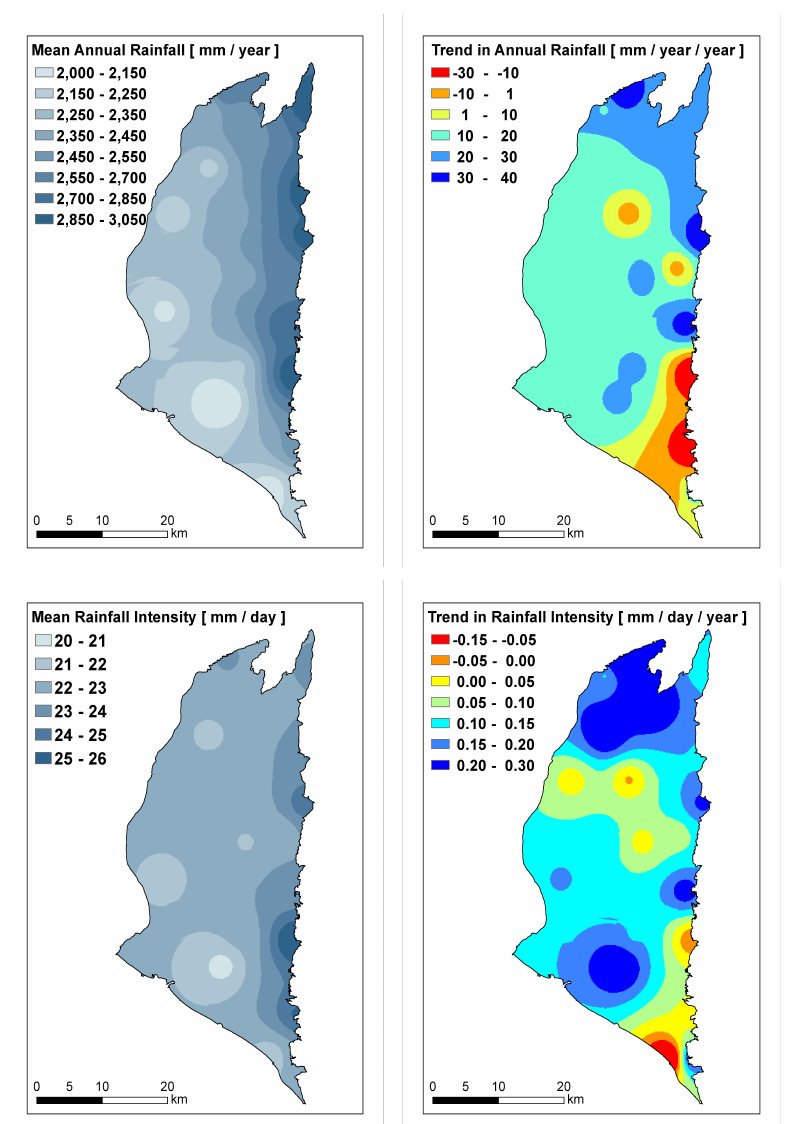
Figure 4. The ( top ) and ( bottom ) panel shows the spatial distribution of annual rainfall amounts (mean rainfall intensity) and the corresponding trend over the